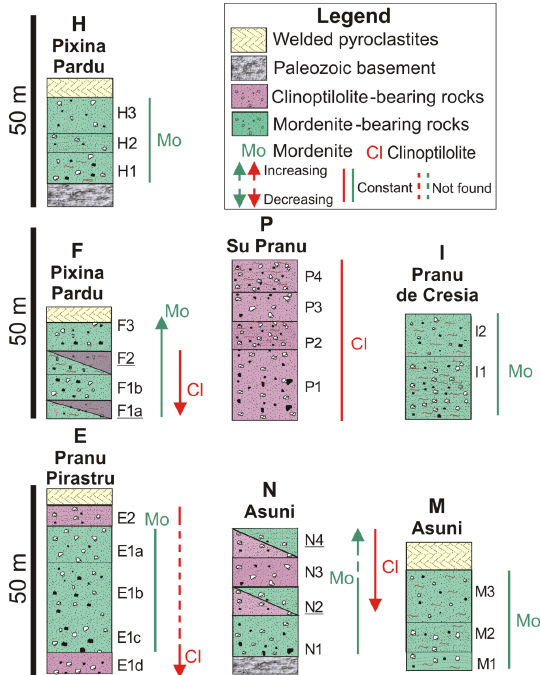
Figure 2. Sketch of sampled stratigraphic sections at the sites in Figure 1, arranged from North-West to South-East and completed by qualitative abundance of secondary minerals. Underlined sample names highlight clinoptilolite and mordenite coexistence. In the legend, the deposits are distinguished based on dominant zeolite. Note: The relative abundance in collected samples allows to infer the vertical trend in the zeolite stratigraphy.